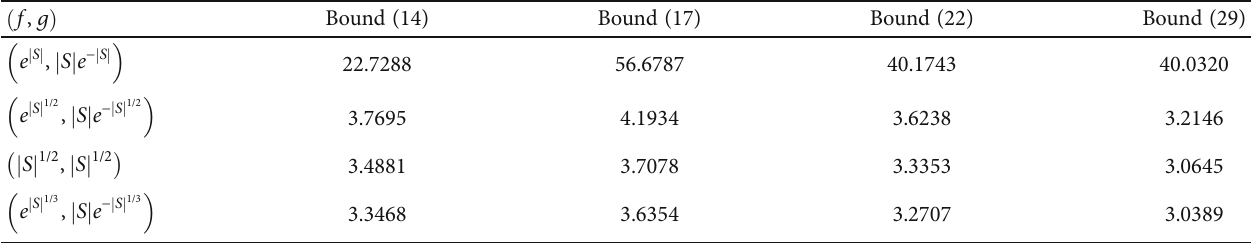
Table 1: Bounds (14), (17), (22), and (29) for di ff erent choices of f and g in (13). f , g ð Þ Bound (14) Bound (17) Bound (22) Bound (29)